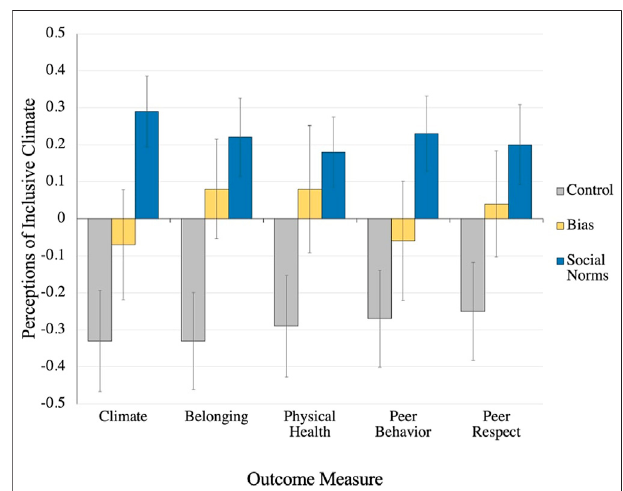
FIGURE2| Effect ofconditiononoutcomesofinterest forstudentsfrom marginalized groups in experiment 5 of Murrar et al., 2020. Note: The authors compared their social norms intervention to a no-exposure control group and an intervention highlighting